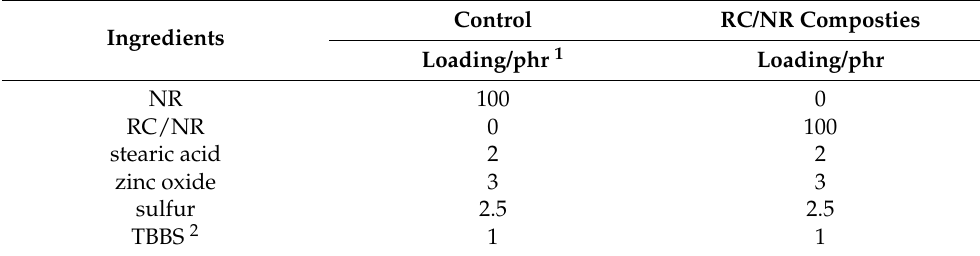
Table 1. Recipes for the rubber compounds. Ingredients